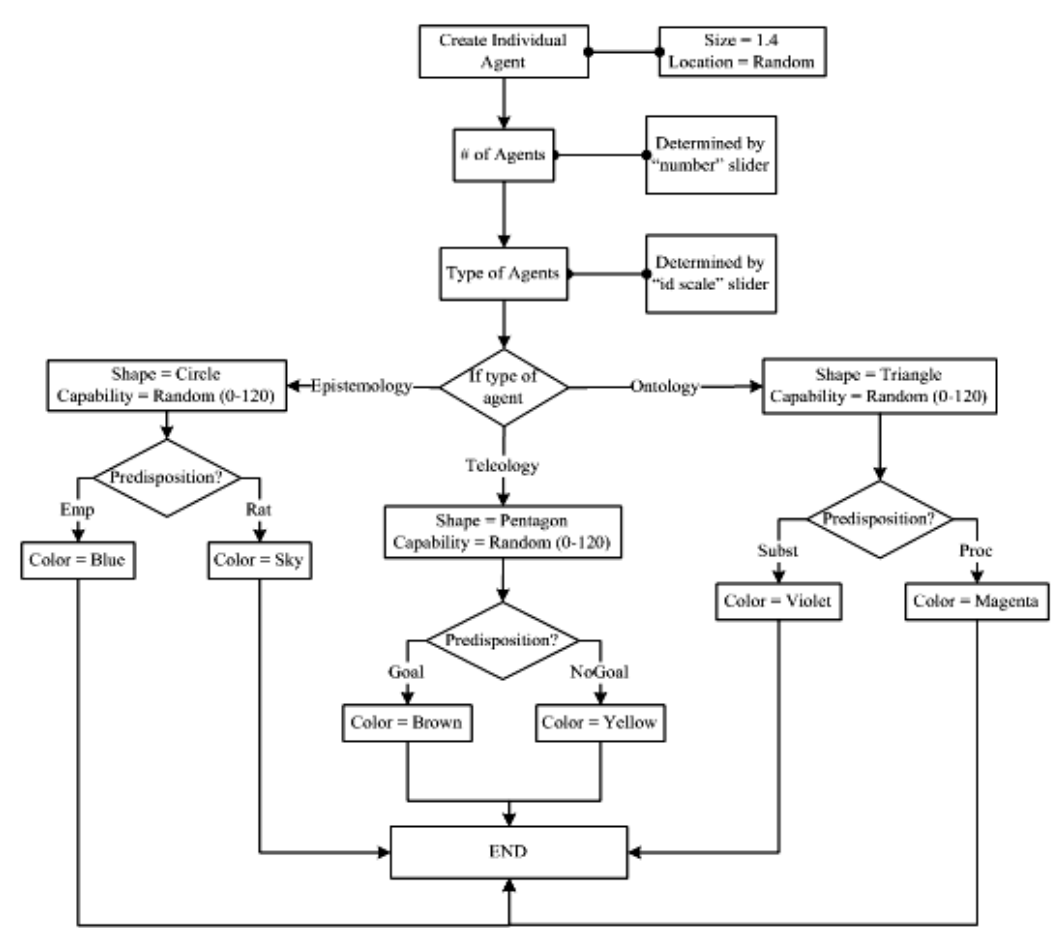
Figure 5. Setup for Individual